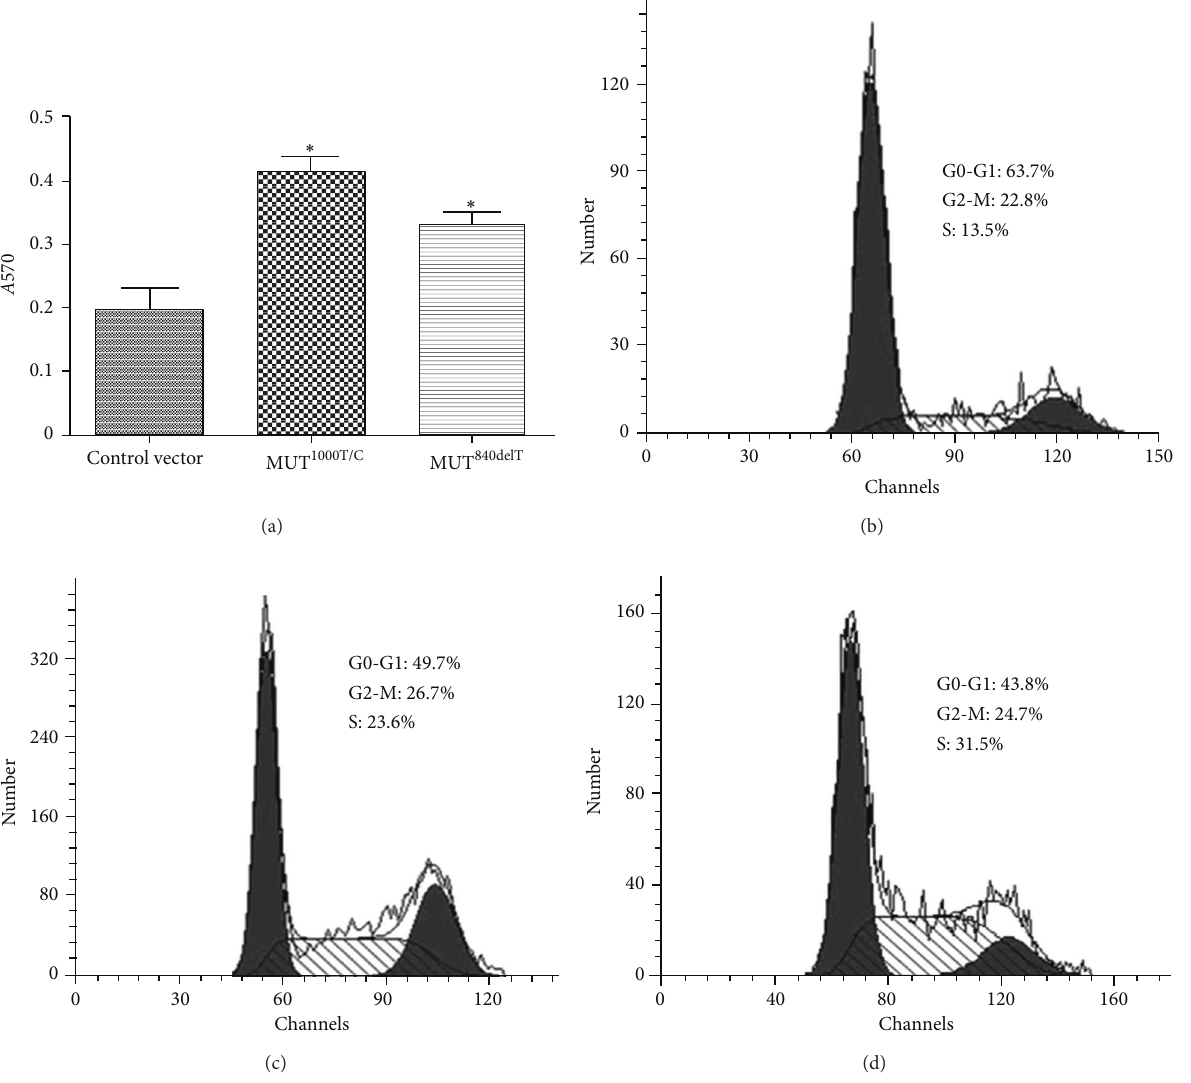
Figure 2: Cell viability and cycle analysis in C20/A4 cells transfected with Wisp3 . Cells stably transfected with MUT 1000 T / C /pcDNA3.1(+), MUT 840 delT /pcDNA3.1(+) or empty vector, and cell viability (a) were determined by MTT and cell cycle was evaluated using flow cytometry. (b) Empty vector; (c) MUT 1000 T / C ; (d) MUT 840 delT . ∗ 𝑃 < 0.01 compared with C20/A4 cells transfected with empty